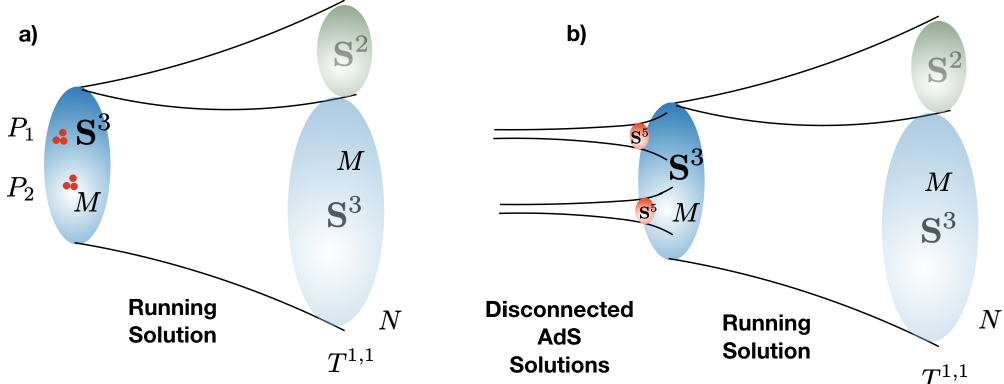
Figure 7 . Picture of a bifid throat with two AdS tongues. It represents a domain wall implementing a cobordism between one theory and a disconnected set of two AdS